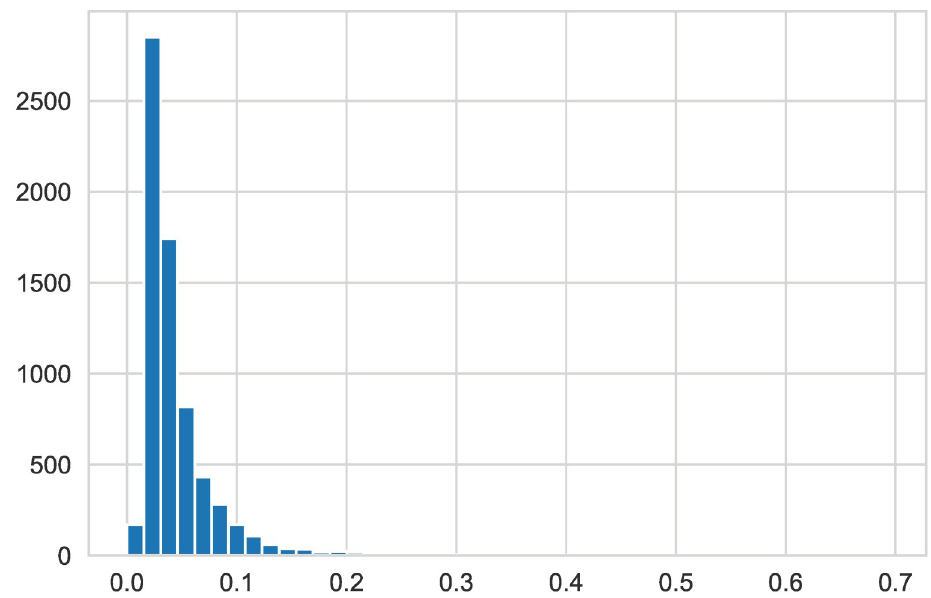
Fig 5. ’Equity to Liability’. A spot check of the ‘Equity to Liability’ skew value reveals that it has reached more than 7.40.